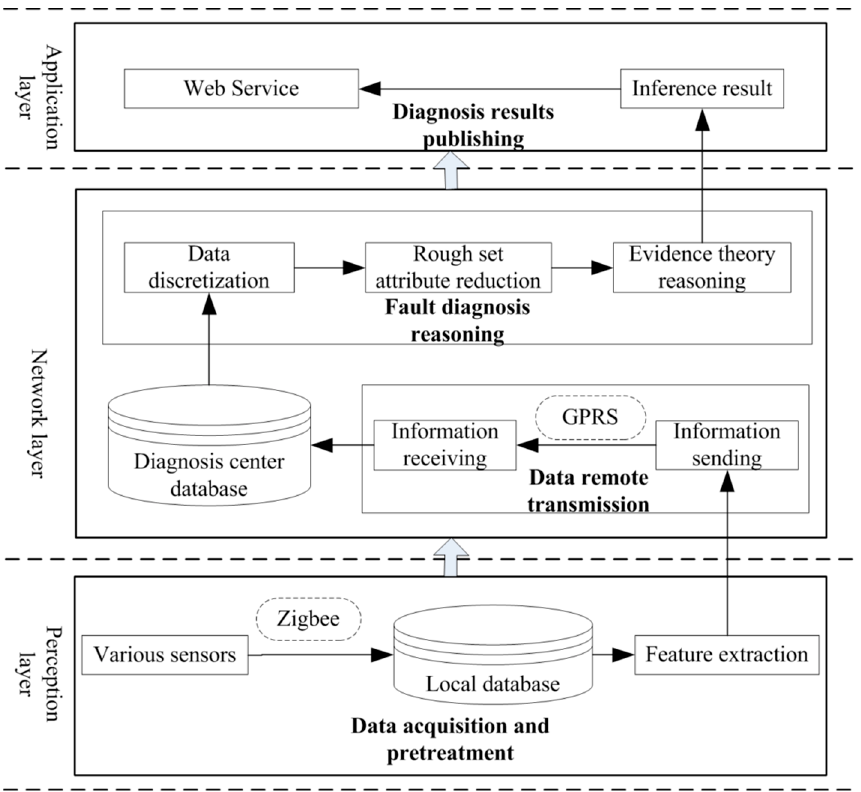
Figure 2. The system structure.